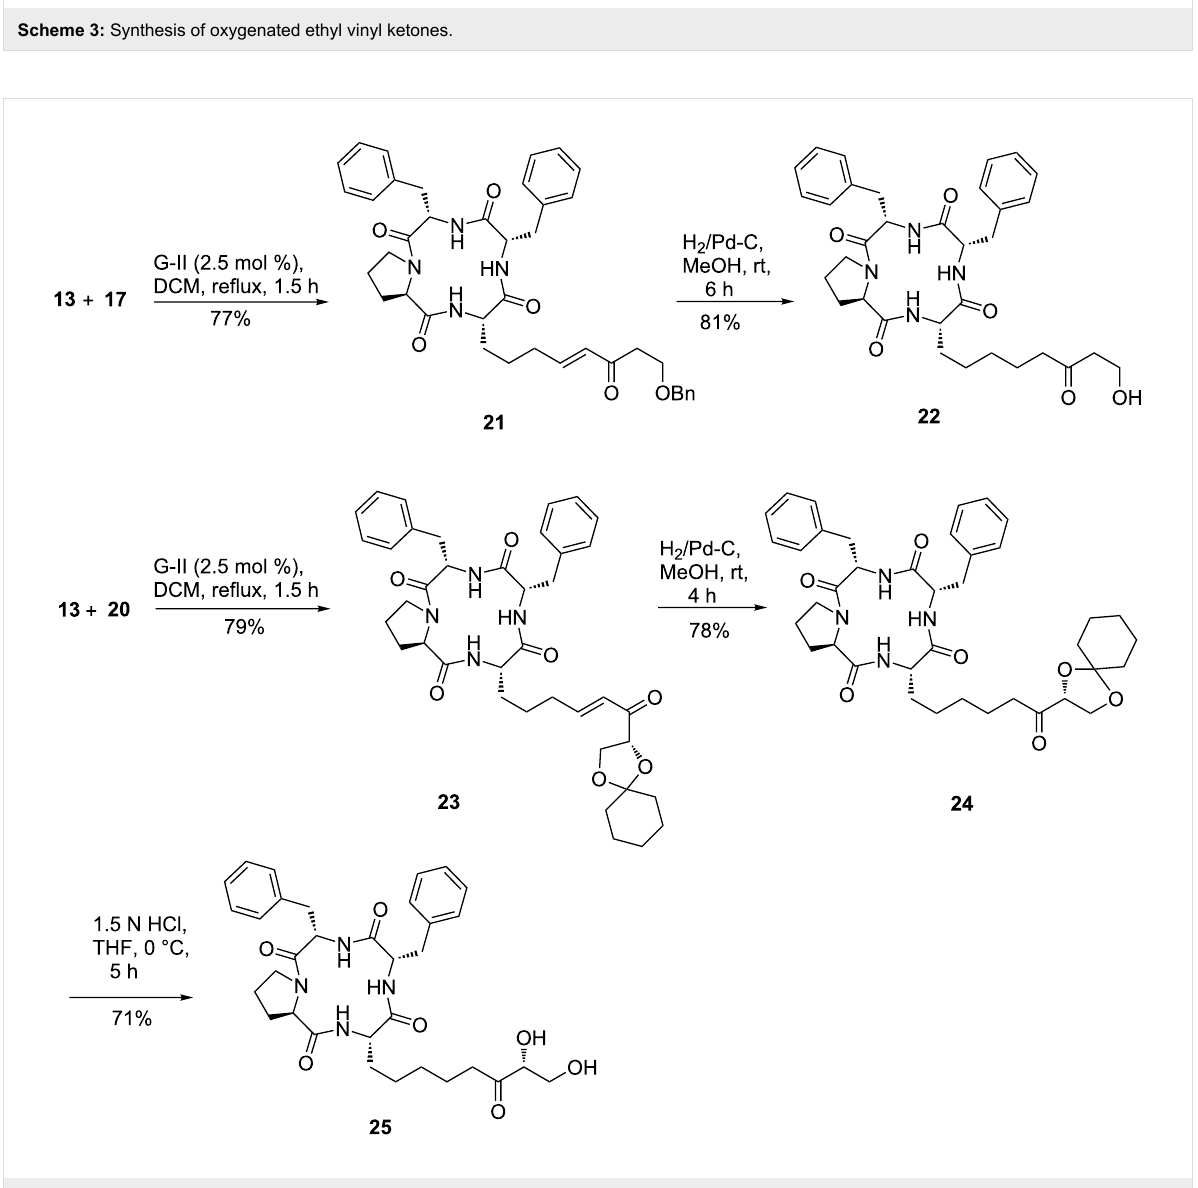
Scheme 4: Synthesis of analogues of